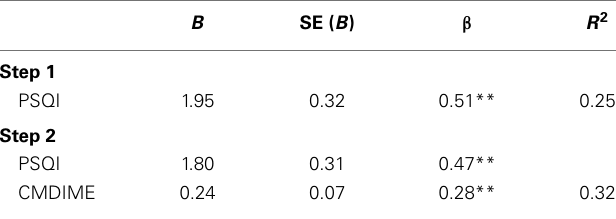
Table 4 | Stepwise hierarchical regression predicting fatigue with disease duration, sleep, and depression as the independent variables